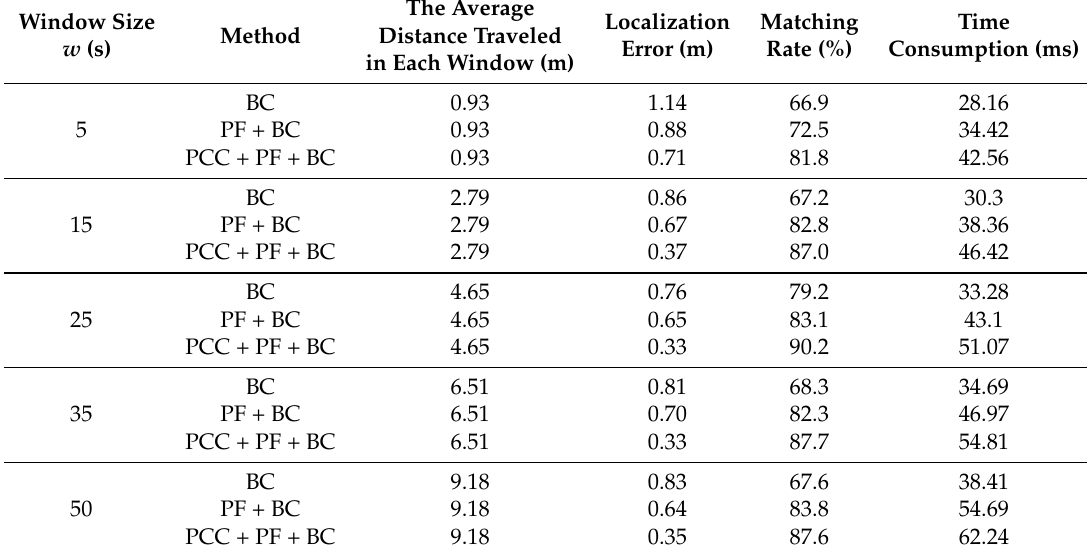
Table 6. The influence of the time window size w on the experimental